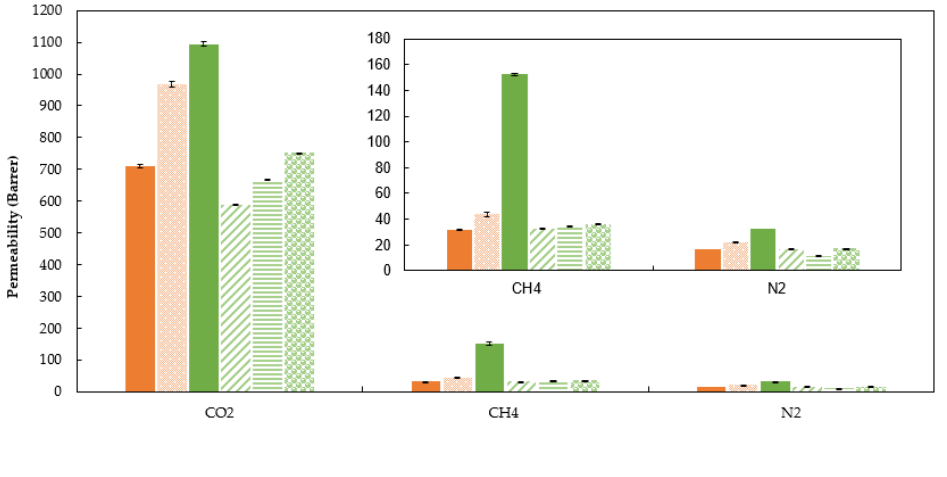
Figure 3. CO 2 , N 2 , and CH 4 gas permeabilities (P) through [C 2 mim][CF 3 BF 3 ] and [C 2 mim][CF 3 SO 2 C(CN) 2 ] SILMs at T = 20 ◦ C. Error bars represent standard deviations based on three experi- mental replicates. In some cases, the standard deviations are very small and cannot be visualized. Values of [C 2 mim][NTf 2 ] were taken from Tom é et al. [28], [C 2 mim][C(CN) 3 ] from Tom é et al. [39], [C 2 mim][TFSAM] from Gouveia et al. [44], and [C 2 mim][BF 4 ] from Li et al.